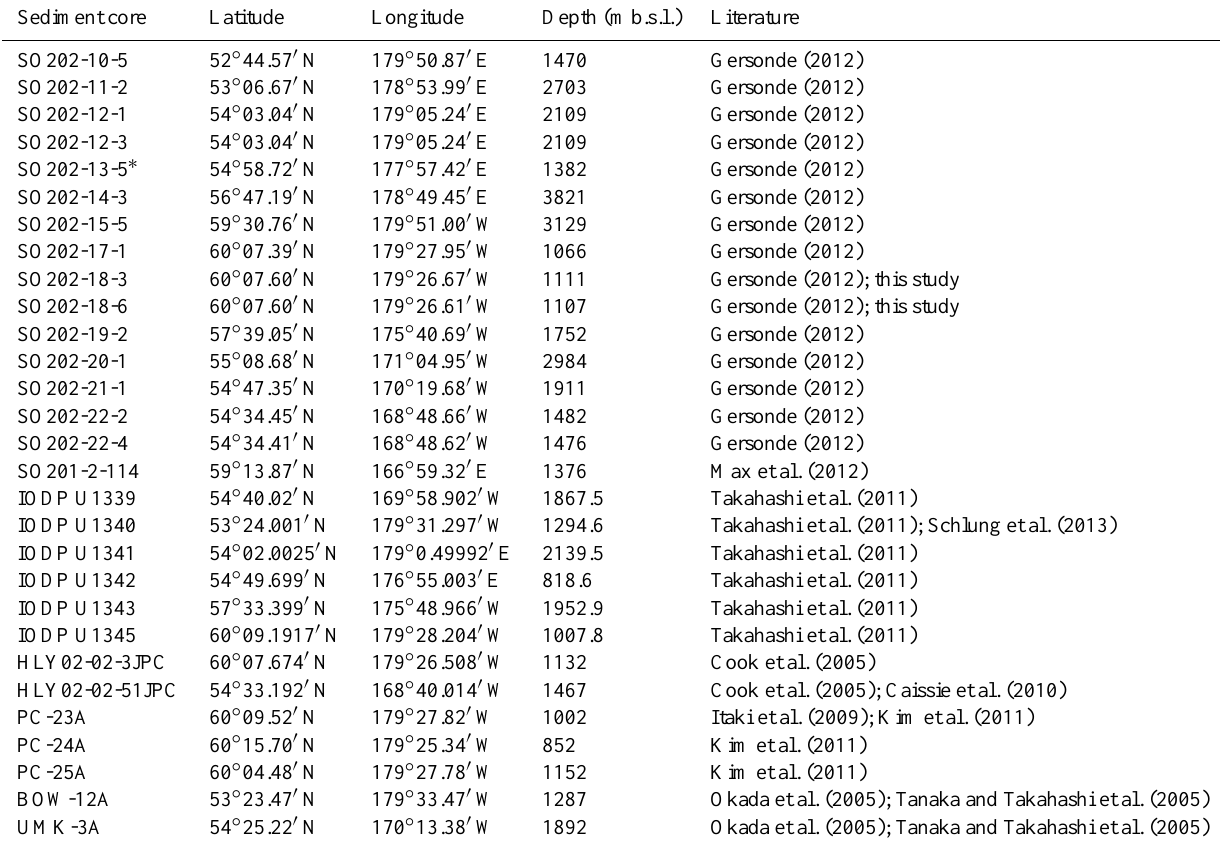
Table 1. Sediment cores from the Bering Sea containing laminated intervals during the last deglaciation. Depths are given in meter below sea level